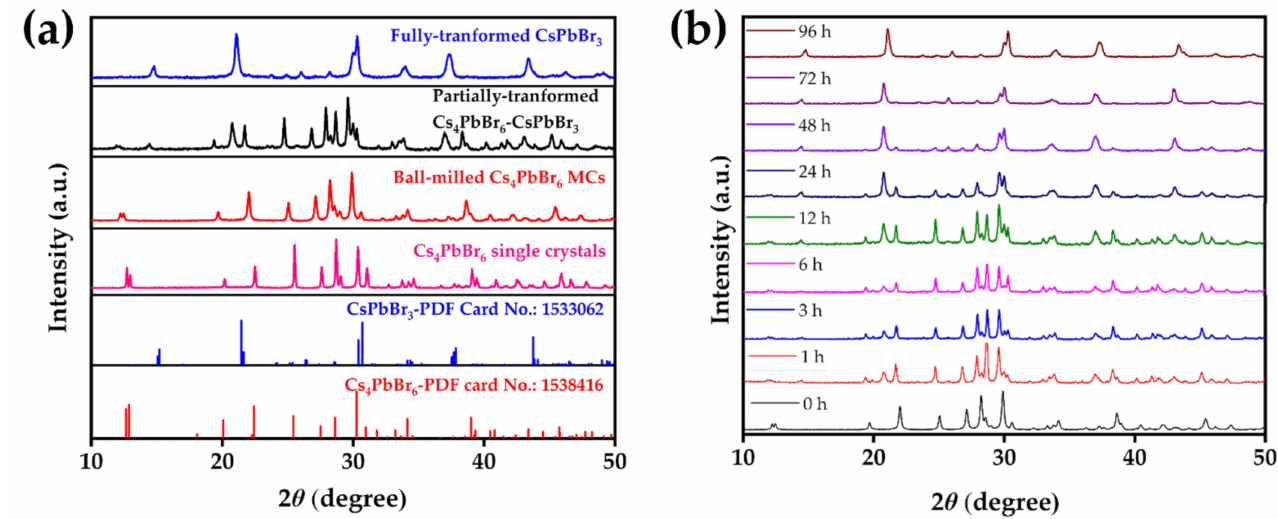
Figure 2. ( a ) XRD spectra of the synthesized bulk Cs 4 PbBr 6 single crystals, Cs 4 PbBr 6 MCs obtained through ball milling, and phase-transformed CsPbBr 3 MCs. The standard XRD spectra of rhombohe- dral Cs 4 PbBr 6 and orthorhombic CsPbBr 3 are also indicated. ( b ) XRD spectra indicating the phase transition of ethanol/water-treated Cs 4 PbBr 6 MCs to CsPbBr 3 MCs with differing times.